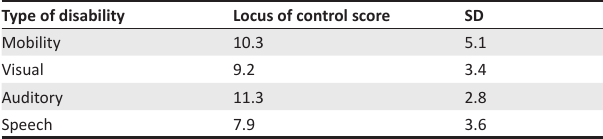
TABLE 3: Summary of internal and external locus of control scores by type of disability.